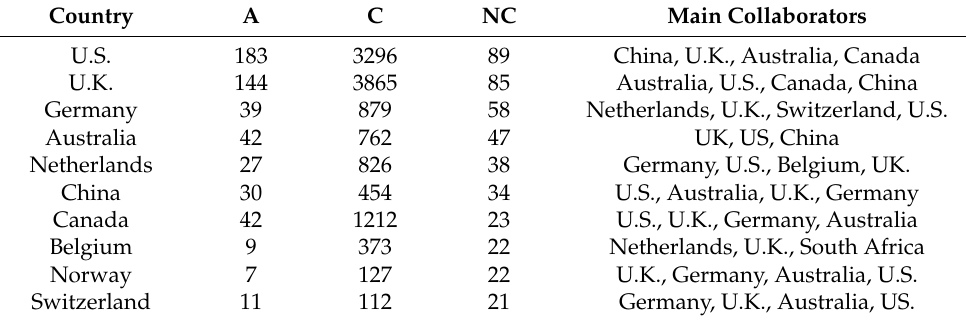
Table 4. Top 10 most cooperative countries and main